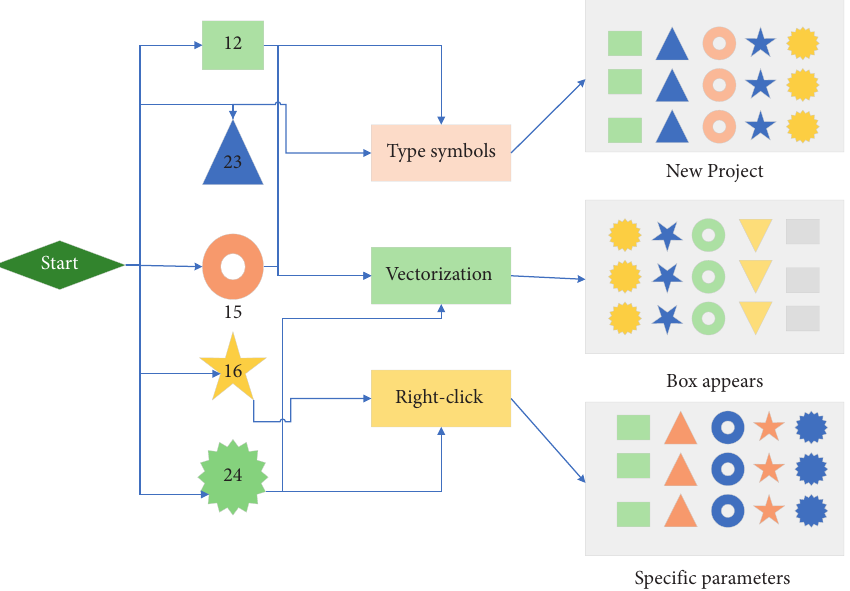
Figure 5: Legend edit dialog.